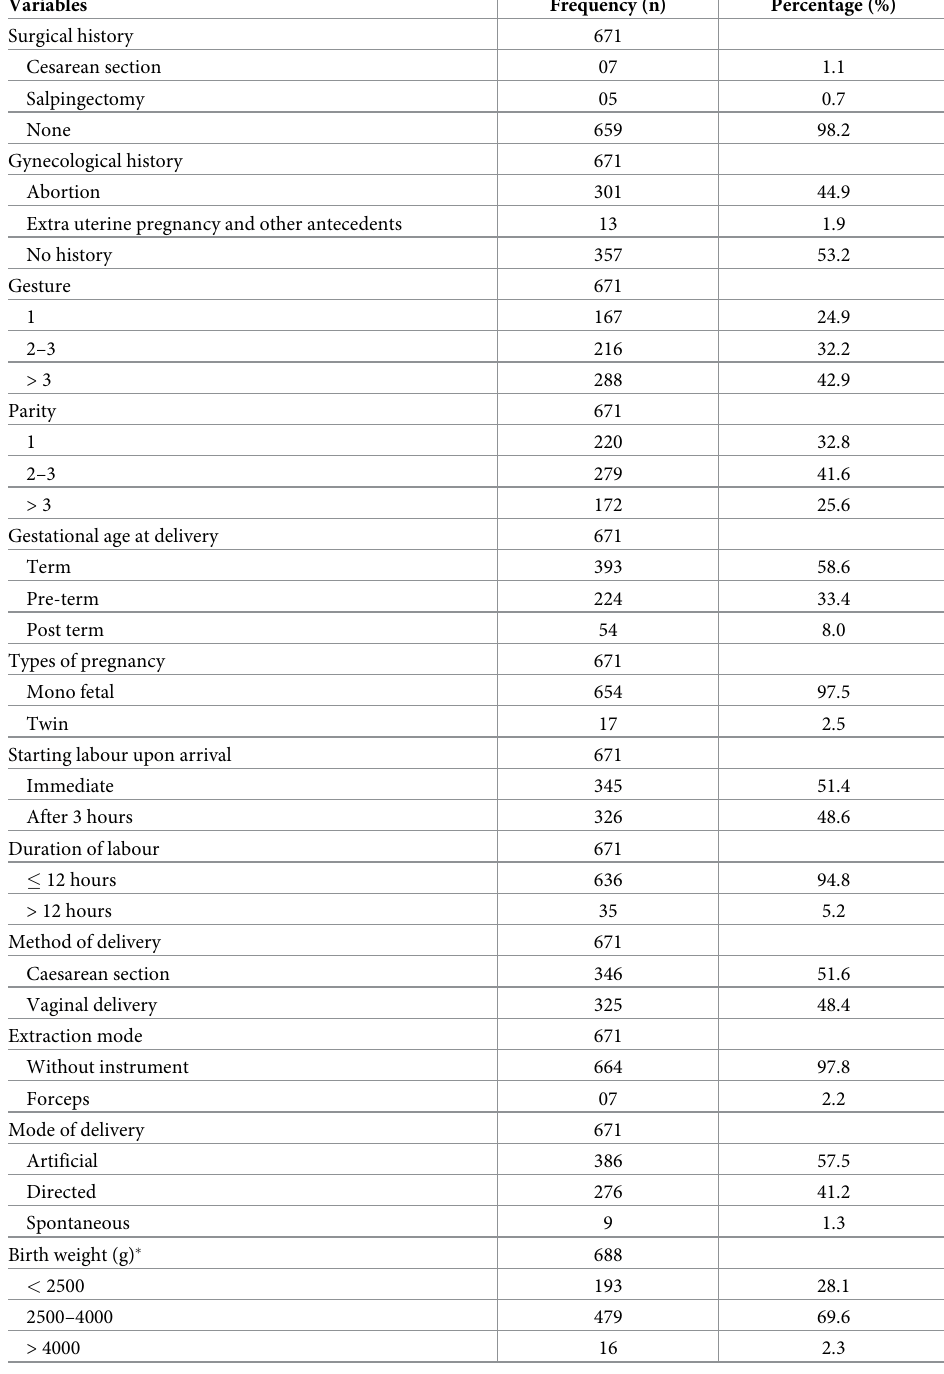
Table 2. Pregnancy and childbirth characteristics of women at Libreville University